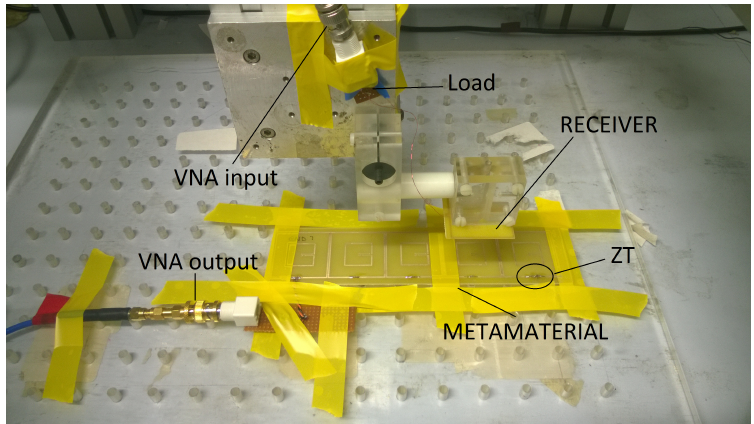
Figure 6. Experimental